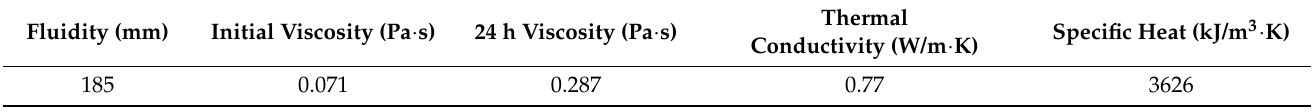
Table 3. Basic physical properties of cable backfill